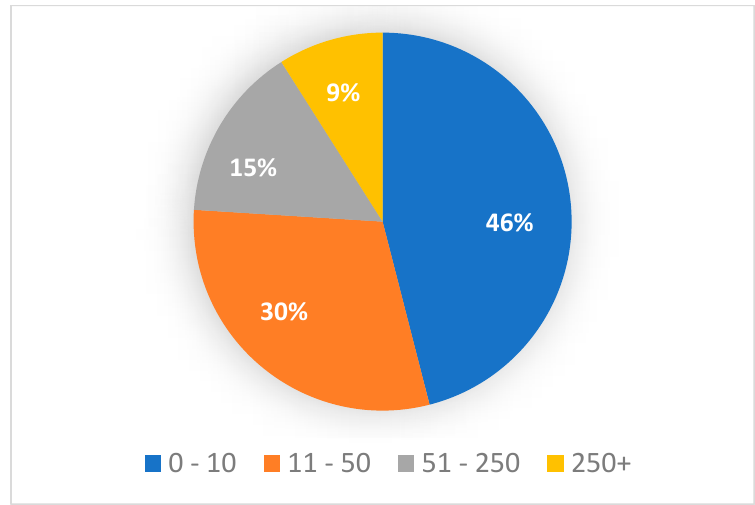
Figure 2. Distribution of companies by number of employees.